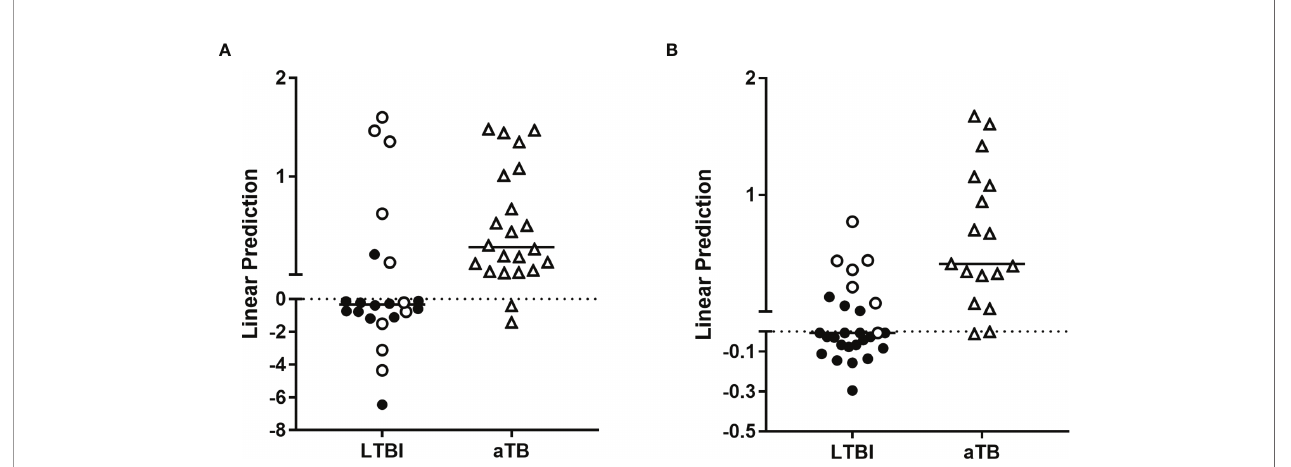
FIGURE 5 | Combination of M. tuberculosis -speci fi c immune markers allowing the distinction between LTBI and aTB in the WB assay. HBHA-IL2, HBHA-GM-CSF and ESAT-6-IP-10 were the host markers selected by logistic regression analysis to be combined for the WB-based assay to discriminate aTB from LTBI. Patients with aTB are indicated by open triangles and LTBI subjects at risk to reactivate the infection by open circles. Results are represented with their linear predictor for the validation (A) and training (B) cohorts. The horizontal lines represent the medians and the dotted lines arbitrary